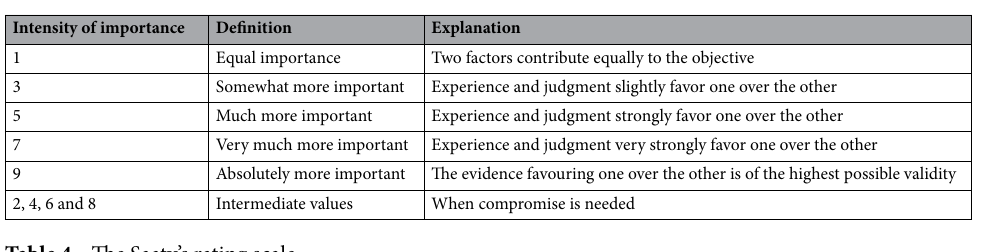
Table 4. The Saaty’s rating